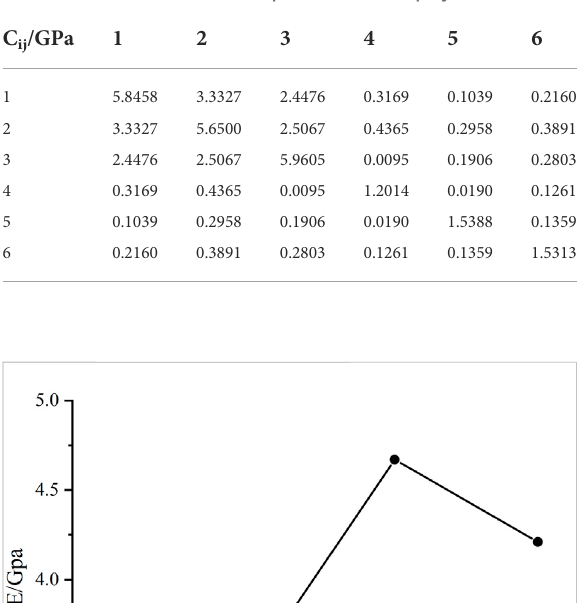
TABLE 3 Stiffness matrix of 20% plasma-modi fi ed polyimide.